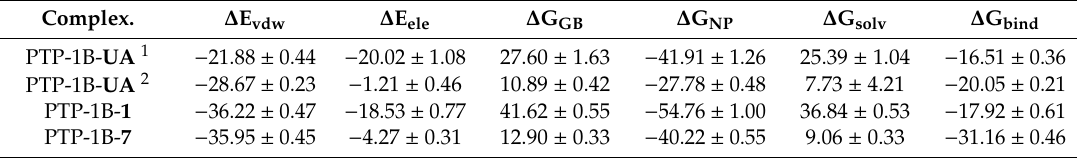
Table 5. Calculations of the theoretical energy components from the trajectories of molecular dynamics. Complex.